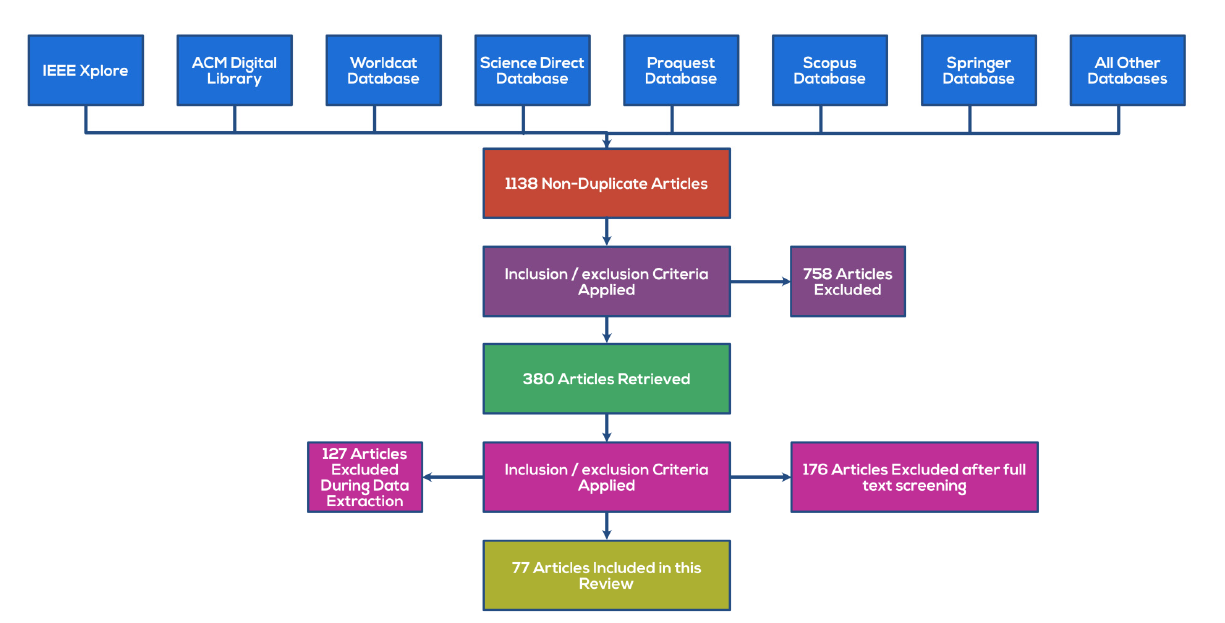
Figure 1. PRISMA flow diagram for the selection process of the research articles used in this review.